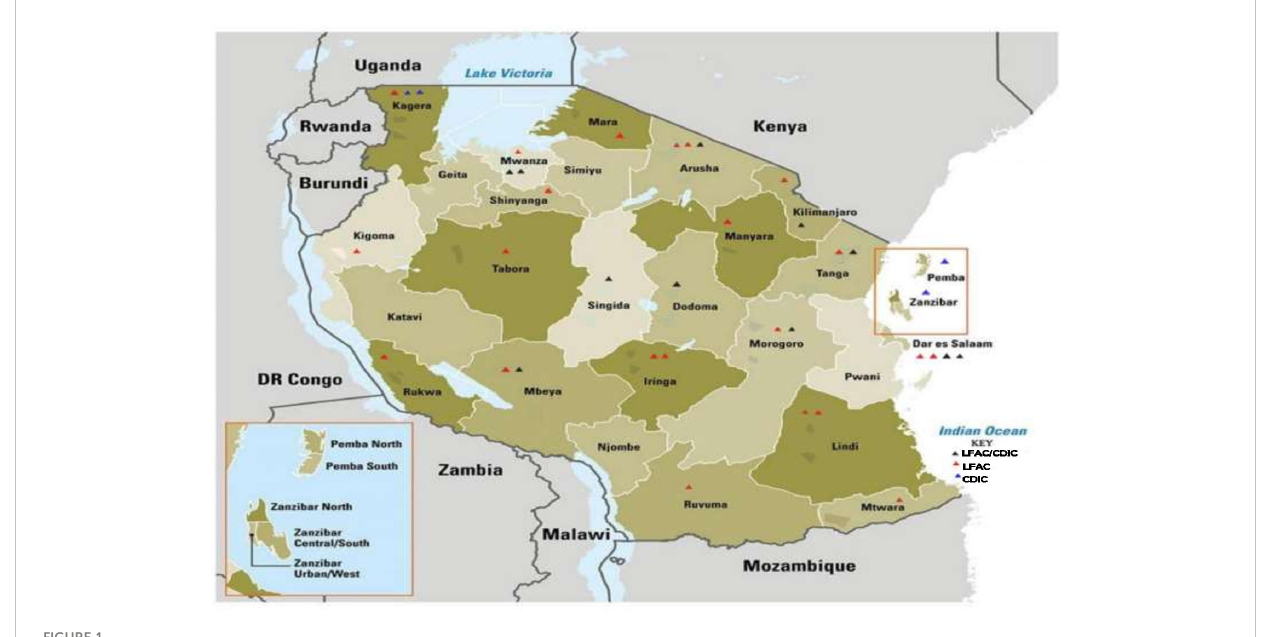
FIGURE 1 Geographical coverage of the type 1 diabetes clinic in